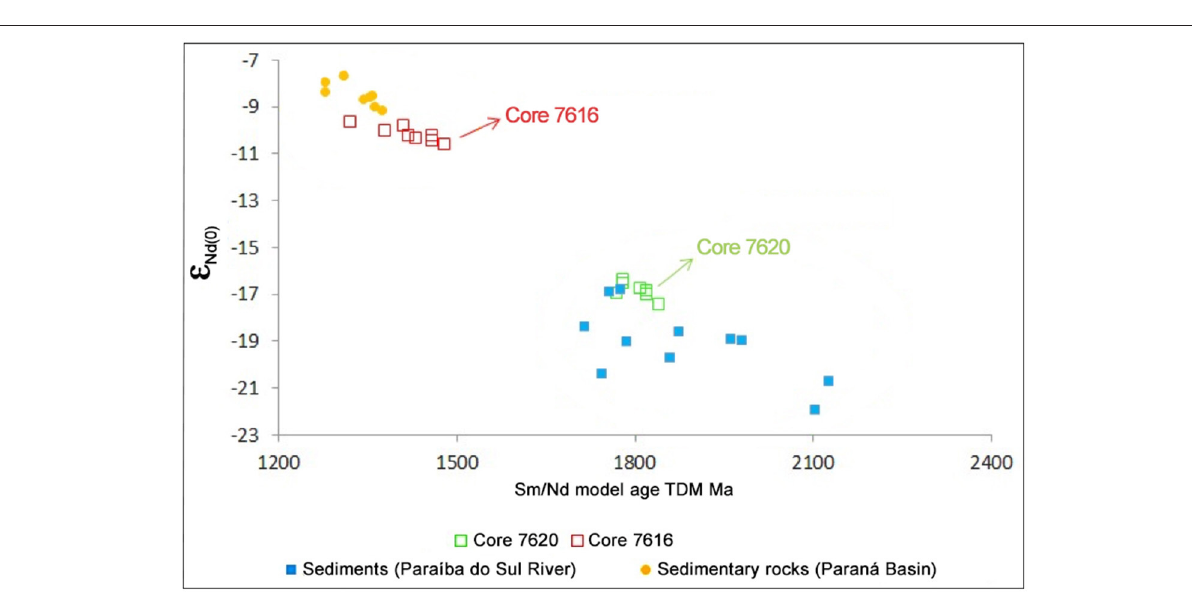
We performed a cluster analysis using the ε Nd(0), 147 Sm / 144 Nd, 143 Nd / 144 Nd, and T DM as parameters of sediment provenance, after obtaining the Principal Component Analysis (PCA) using the Past v.2.17 software (Hammer et al., 2001).